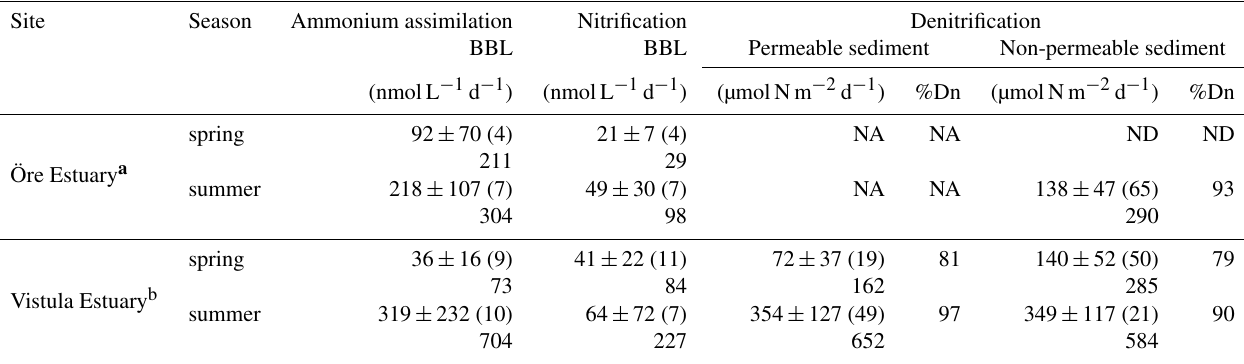
Figure 6. Correlations of nitrification rates with the PON concentration (a) and particulate C : N ratio (b) and of ammonium assimilation rates with the PON concentration (c) and particulate C : N ratio (d) in the BBL; coupled nitrification–denitrification rates with LOI (e) and the particulate C : N ratio (f) in the sediment of Vistula (VE) and Öre (ÖE) estuaries. Solid lines indicate significant correlations. Table 4. Rates of ammonium assimilation and nitrification in the BBL and of denitrification in the sediments of the Öre and Vistula estuaries in spring and summer. Öre Estuary sediments are non-permeable; thus no rates are available in the permeable sediments (NA). Denitrification in the Öre Estuary in spring was not detectable (ND). All rates are given as average and standard deviation, with the number of replicates in parentheses; the maximum rate is shown below. %Dn gives the share of coupled nitrification–denitrification in total